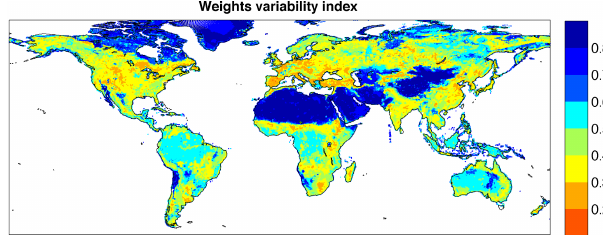
Figure 13. Relative annual variability of the global weights extrap- olated by 84 different NNs. Smaller (larger) values indicate lower (higher) variability. See the text for